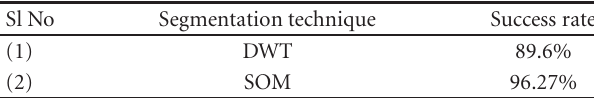
Table 2: Formant Frequency for various vowels. Table 3: DWT versus SOM segmentation success